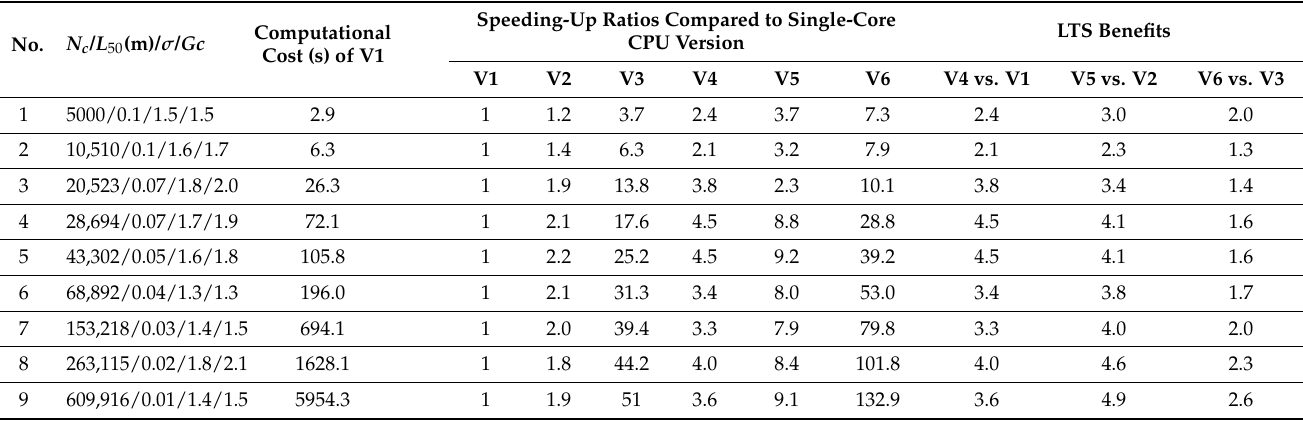
Table 3. Statistics for simulations of the scenario of dam-break flow propagating through